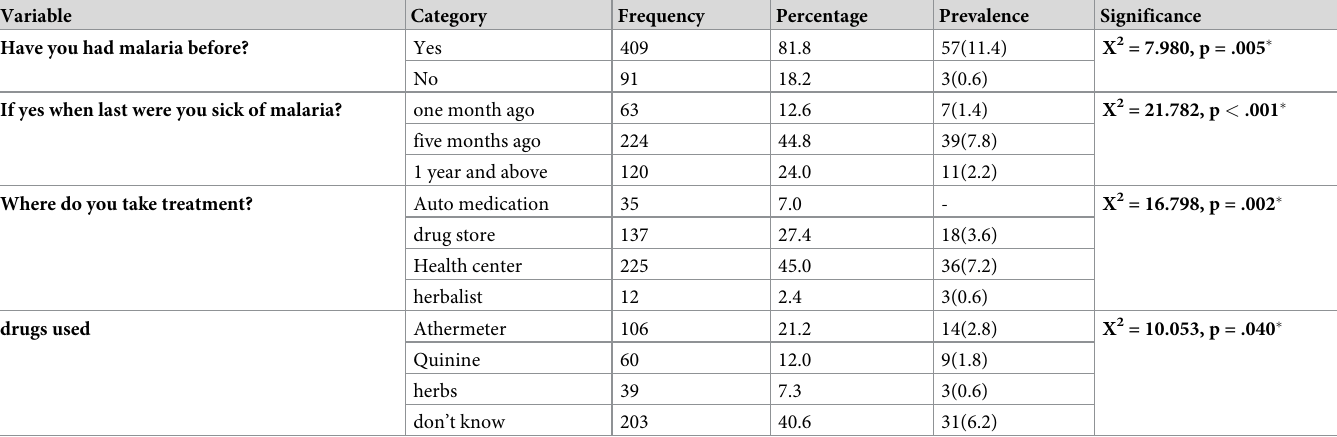
Table 4. Prevalence of malaria in relation to malaria management characteristics of